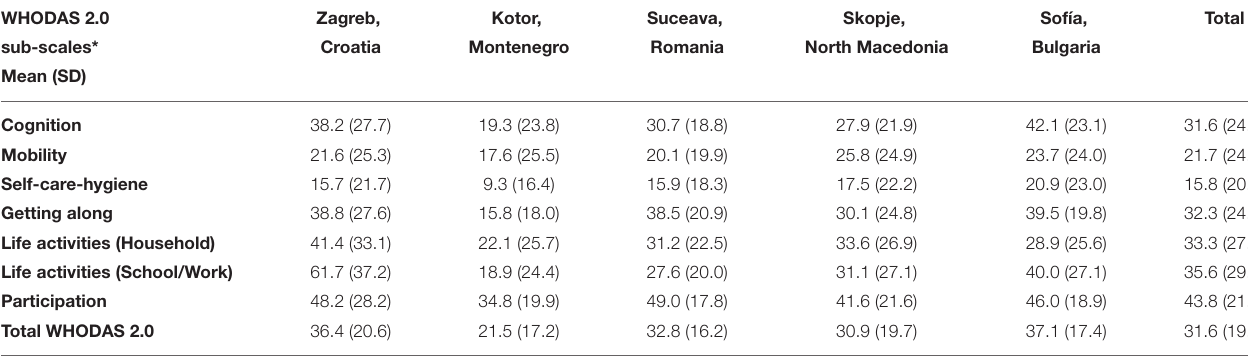
TABLE 2 | WHO Disability Assessment Schedule 2.0 sub-scales per project site and for the total sample. WHODAS 2.0 Zagreb, Kotor, Suceava, Skopje, Sofía, Total sub-scales* Croatia Montenegro Romania North Macedonia Bulgaria